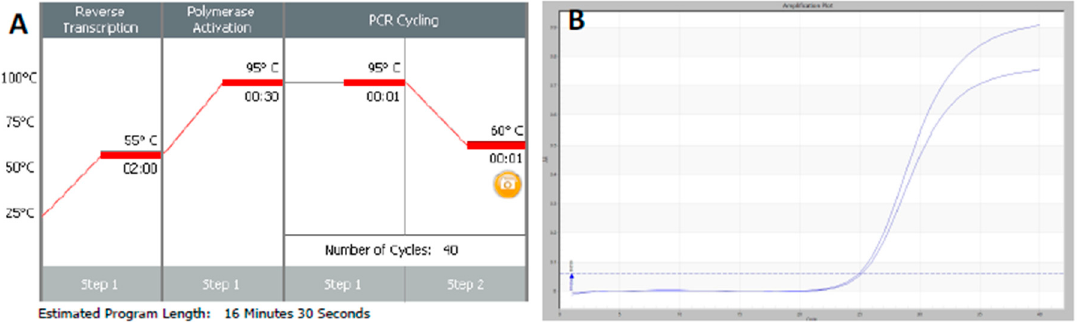
Figure 3. Amplification of SARS-CoV-2 using a fluorescence-based RT-qPCR assay. A. Thermal profile of a typical fast RT-qPCR test. The RT step can be carried out at a range of temperatures, here Superscript IV at 55 ◦ C, for di ff erent lengths of time, here 2 min. A polymerase activation step deactivates the RT and activates Taq polymerase, here SensiFast (Bioline), with the time dependent on which polymerase is being used. PCR cycling steps in this example are 40 cycles at 95 ◦ C (denaturation) and 1 s at 60 ◦ C (annealing / polymerisation), allowing the RT-qPCR run to be completed in around 17 min. As this is a RT-qPCR run, at the end of each cycle fluorescence intensity is read to establish the amount of PCR product generated. B. Amplification plot generated using the above protocol, with the assay run as a duplicate RT-qPCR using OneStep (PCRBio) kit. The primer and probe sequences were (5 (cid:48) -3 (cid:48) ) F: GGATCAAGAATCCTTTGGTGG; R: GTCACAAAATCCTTTAGGATTTGGA; Probe: FAM-. CATCGTGTTGTCTGTACTGCCGTTGCC-BHQ